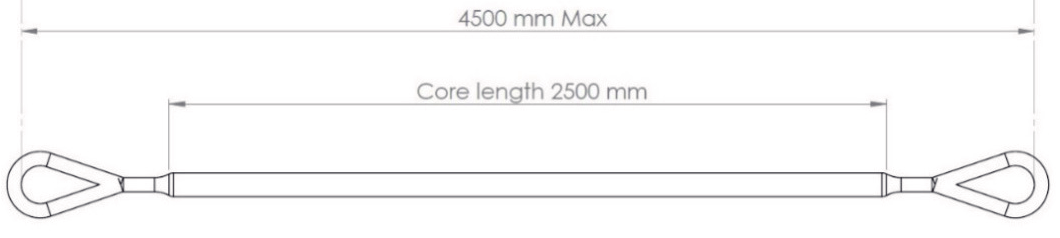
Figure 3. Working length (core length) and overall length of the P1 tethers (except